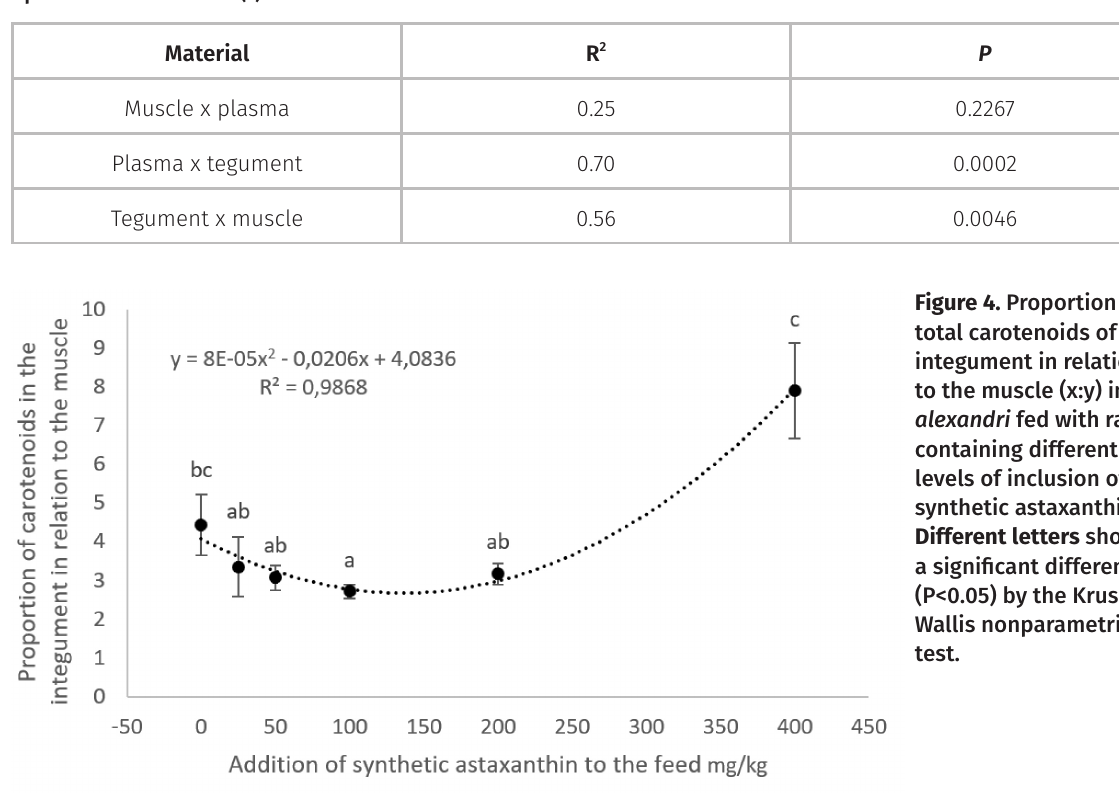
Table III. Correlation between tecidual and plasma levels of total carotenoid content in L. alexandri analyzed by Spearman correlation ( r ).